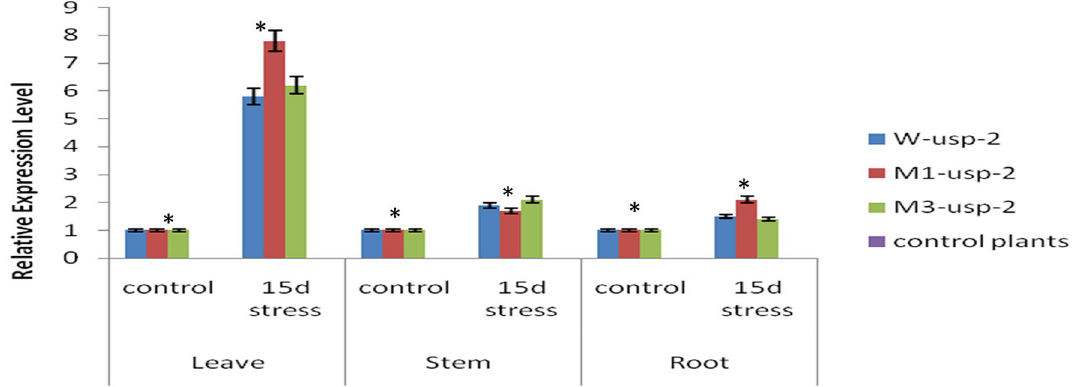
Figure 10. Spatial Expression of wild type and mutated GUSP-2 genes in transgenic plants under drought stress conditions.